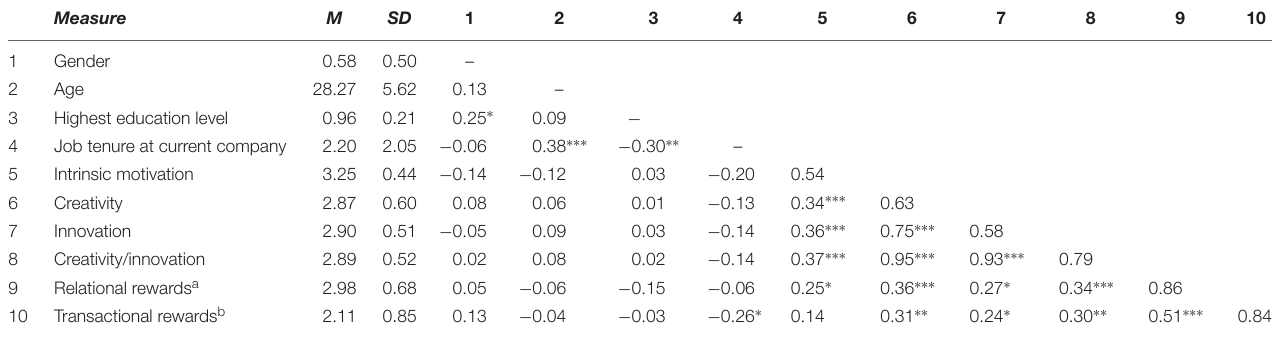
TABLE 2 | Means, standard deviations, and intercorrelation among study variables.